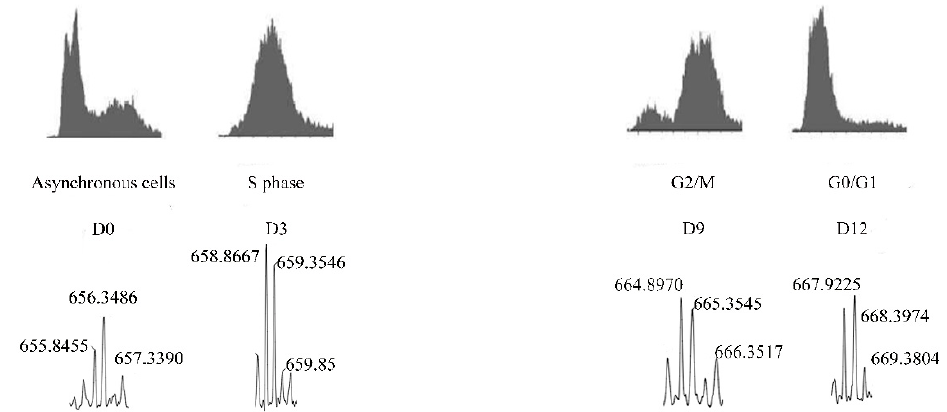
Figure 3. Schematic representation of isotopic-labeling of peptide-containing cellular extracts isolated in different phases of the cell cycle of the Hela cell line. Peptides were extracted from the asynchronous cells and labeled with D0-TMAB, whereas those synchronized in S, G2/M, and G0/G1 were, respectively, labeled with D3-TMAB, D9-TMAB, or D12-TMAB.